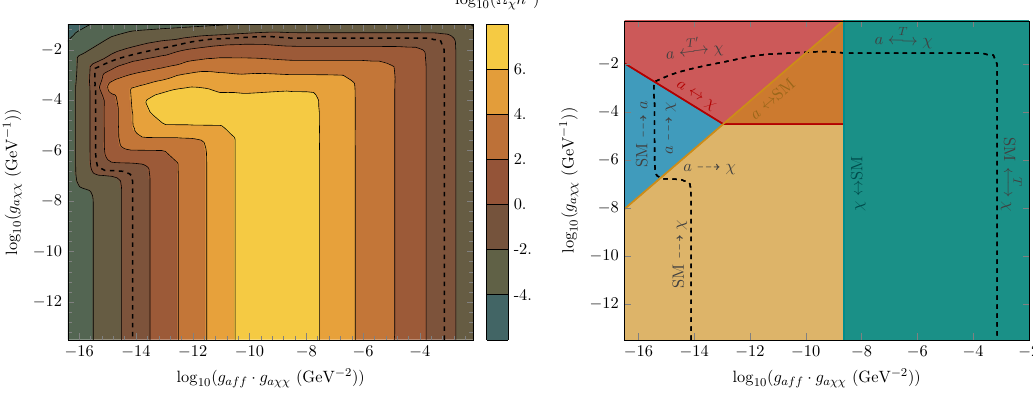
Figure 4 . Hidden sector coupling g aχχ as a function of the product of the hidden sector and the ALP-fermion coupling, g , for m = 10 GeV and m = 1 GeV. The dashed line corresponds aχχ · g aff χ a to the combination of couplings which give the correct DM relic density Ω 2 = 0 . 12 as measured DM h by the Planck telescope. Left: Contour plot of the DM relic density as a function of g and aχχ · g aff g aff , giving the so-called “Mesa” phase diagram: For our choice of masses six different DM genesis scenarios are possible, namely freeze-in from the SM, freeze-in from ALPs, sequential freeze-in, decoupled freeze-out (DFO), freeze-out from the hidden sector and freeze-out from the SM. Right: Different phases of the diagram, corresponding to equilibrium relations between the three